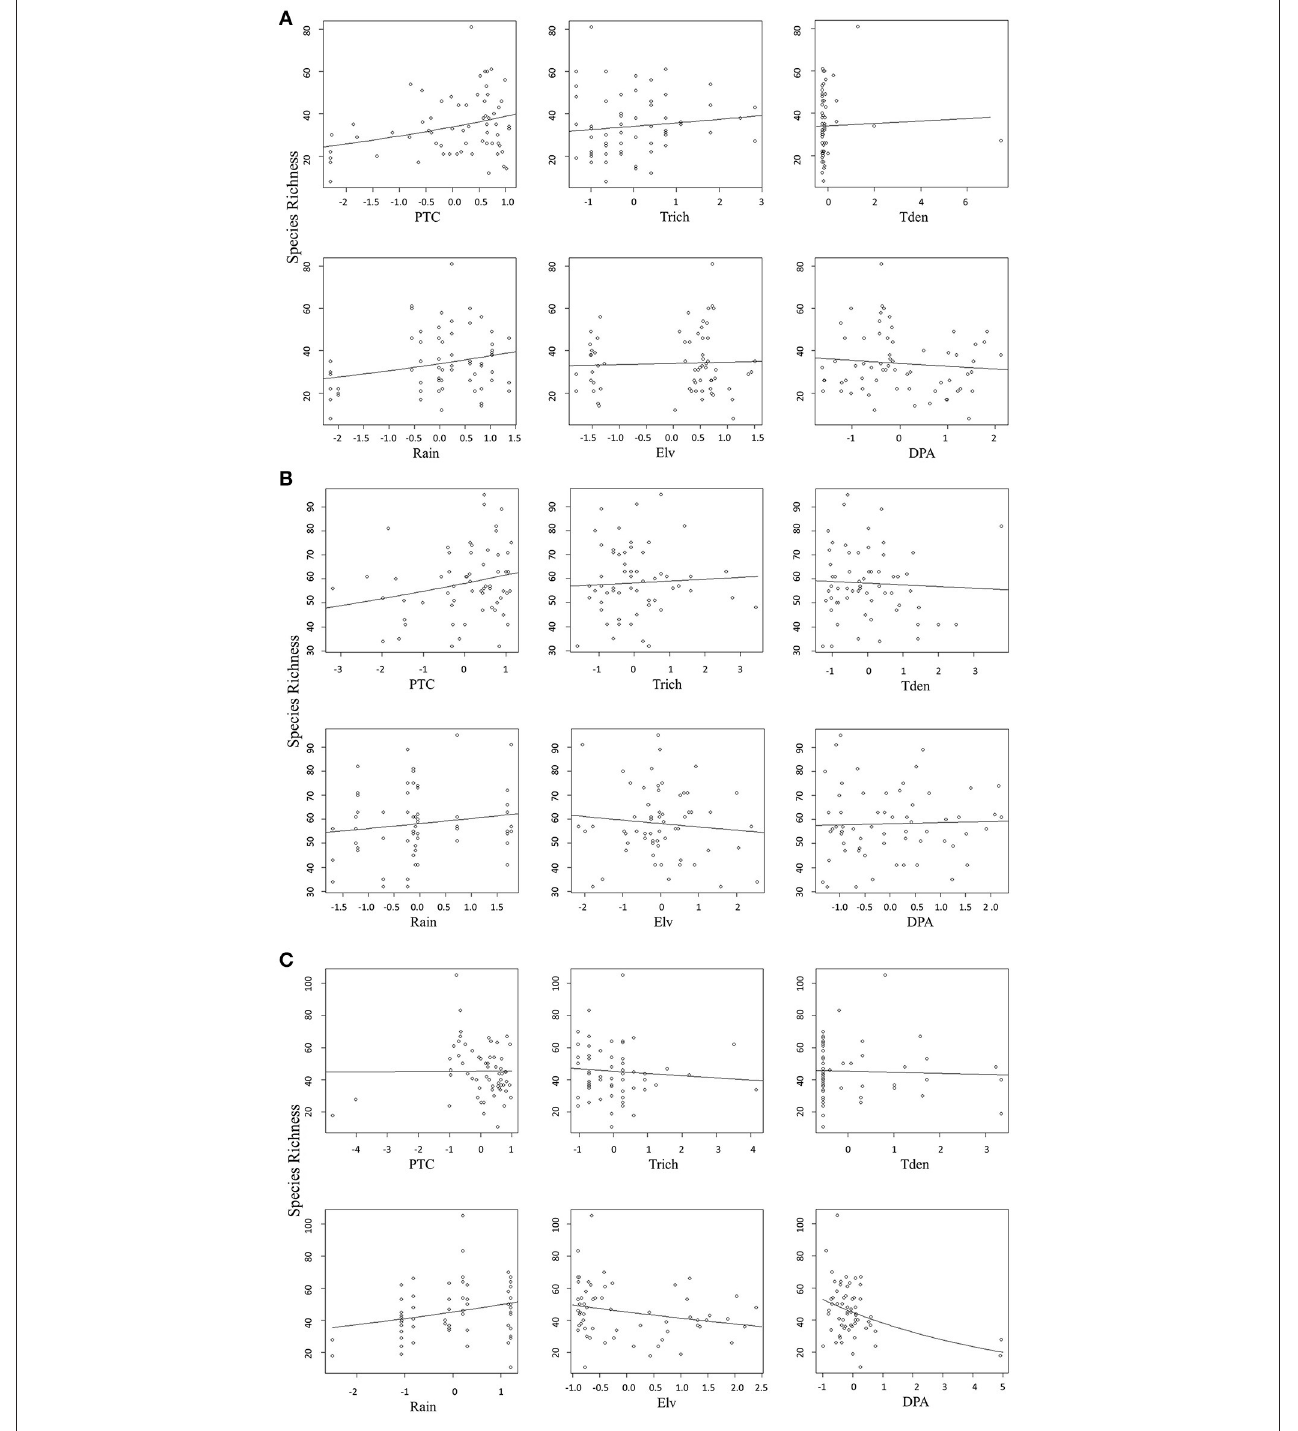
FIGURE 4 | (A) Relationship between predictors and bird species richness in areca agroforests. (B) Relationship between predictors and bird species richness in coffee agroforests. (C) Relationship between each predictor and bird species richness in rubber agroforests.